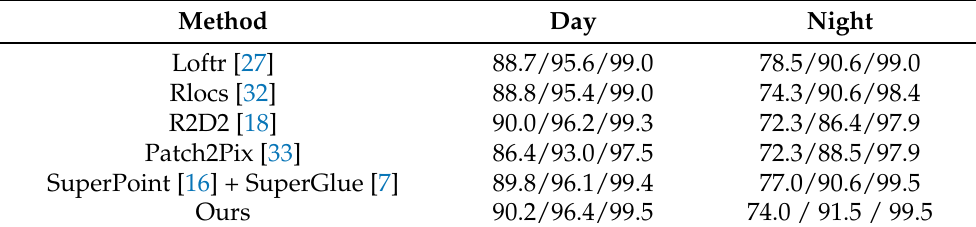
Table 3. Evaluation of State-of-the-art Approaches on Aachen Day-Night v1.1.